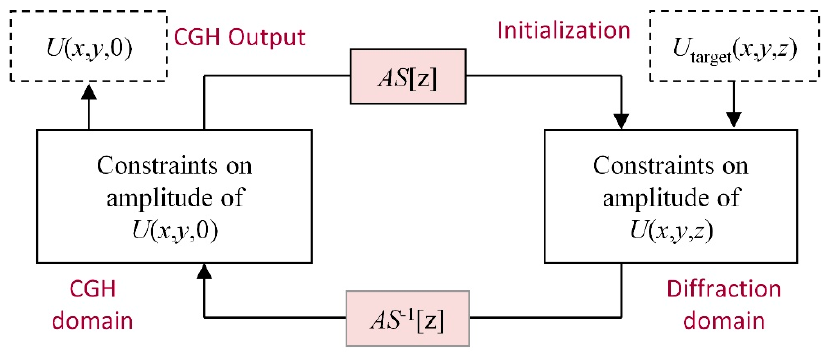
Figure 2. Iterative angular spectrum algorithm (IASA) for near-field CGH design.